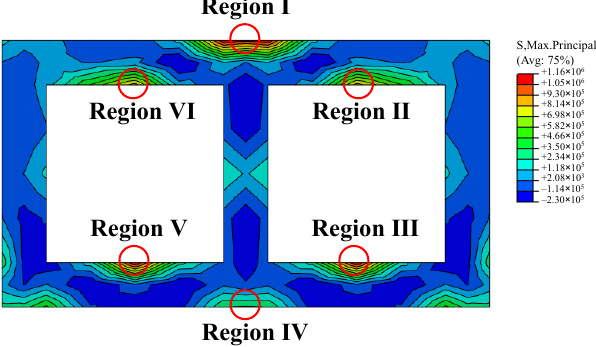
Figure 11. Initial state maximum tensile stress cloud.